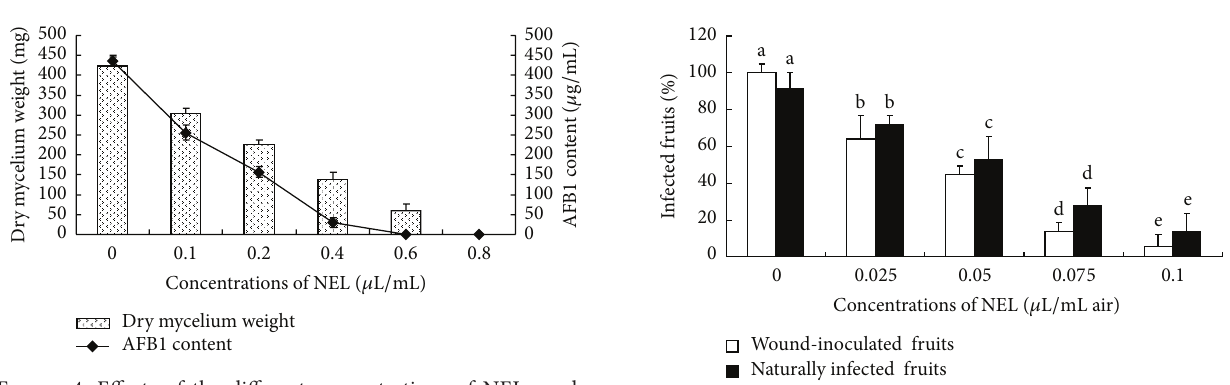
Figure 4: Effects of the different concentrations of NEL on dry myceliumweightandAFB 1 productionby A.flavus. Valuesaremean ( 𝑛 = 3 ) ± standard deviations.